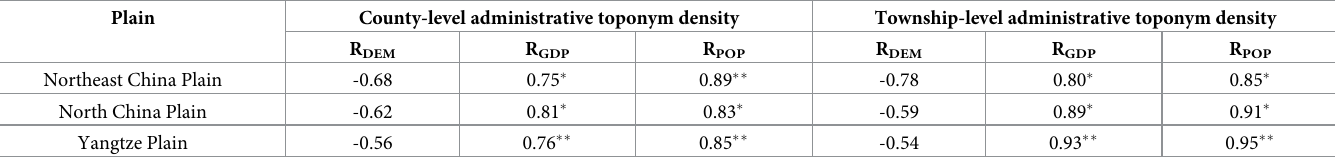
Table 5. Correlation coefficients between administrative toponym density and DEM, GDP, and population density. Plain